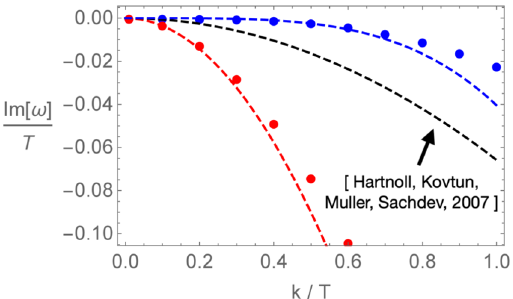
Figure 3. Gapless modes at µ/T = 5 , H/T 2 = 10 : figure 2f. All dots are quasi-normal modes. Red dashed line is the diffusion mode (2.24) and the blue dashed line is subdiffusive mode (2.25). Black dashed line is the diffusion mode given in